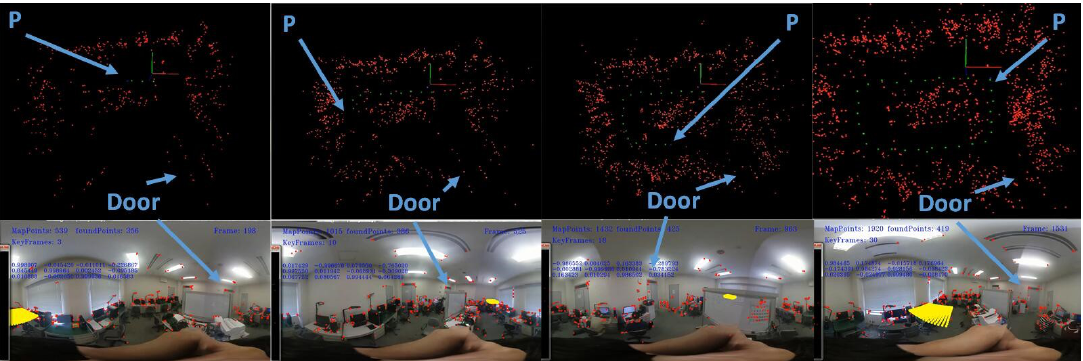
Figure 13. Sample frames from the indoor test.